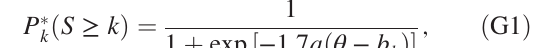
FIG. 7. Effect size as a function of the correlation coefficient estimated using Eq. (7) for the 37 ConcepTests. Horizontal lines correspond to values for small (0.2), medium (0.5), large (0.8), and very large (1.2) effect sizes. The vertical line corresponds to ρ ¼ 0 . 3 .